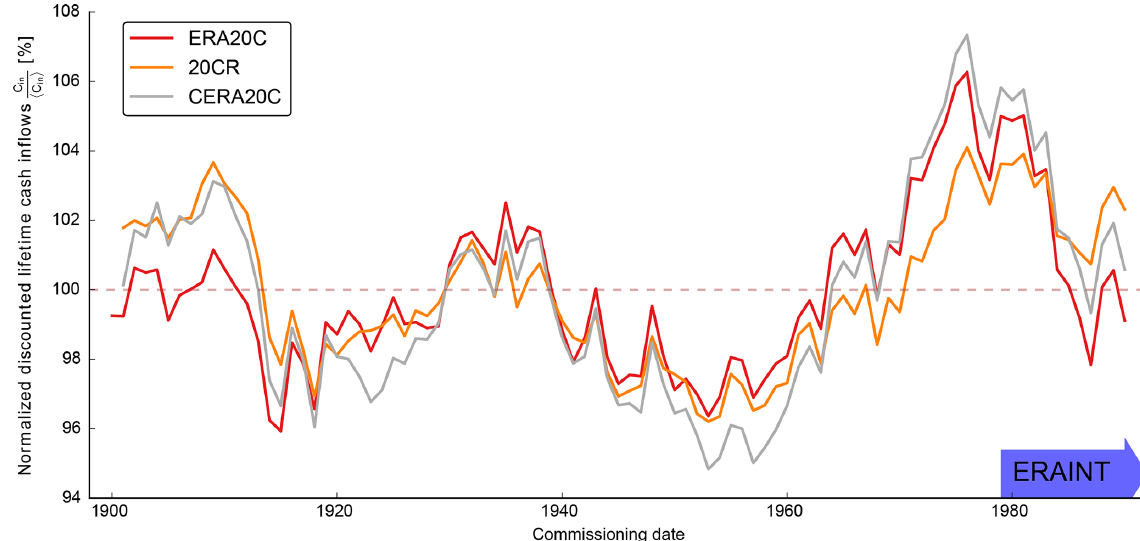
Figure 6. Long-term evolution of normalized discounted lifetime cash inflows of a wind park whose generation follows the German mean. A lifetime of 20 years, aging of 1.5%yr − 1 and a discount rate of 5.5%yr − 1 are assumed. The time series ends in 1990 because the underlying reanalyses end in